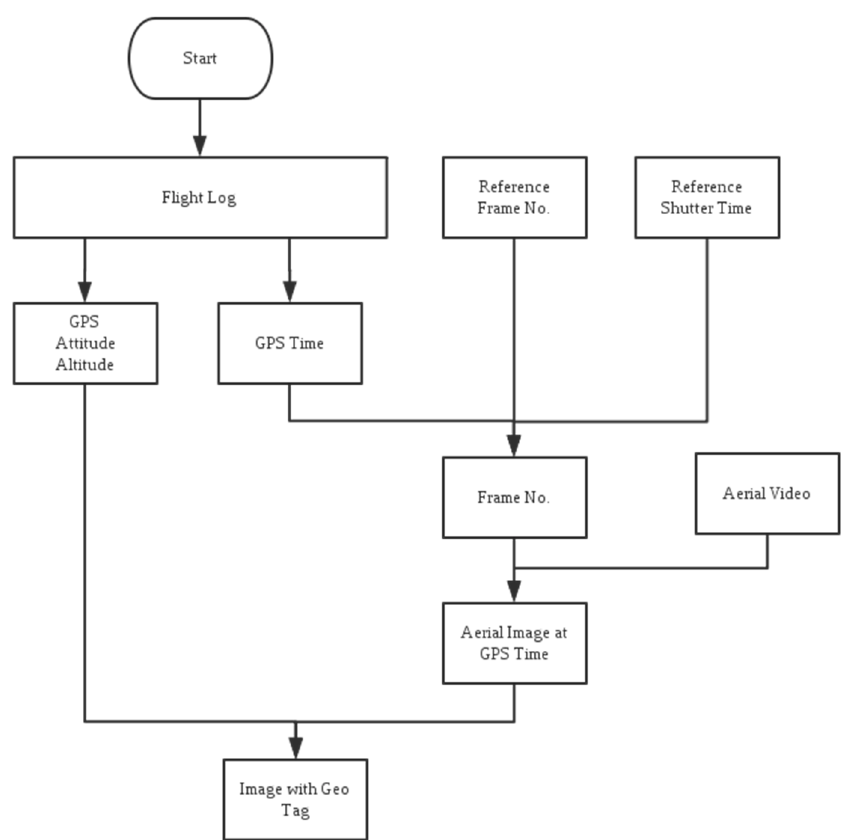
Figure 18. Flowchart of the mapping image capture program.